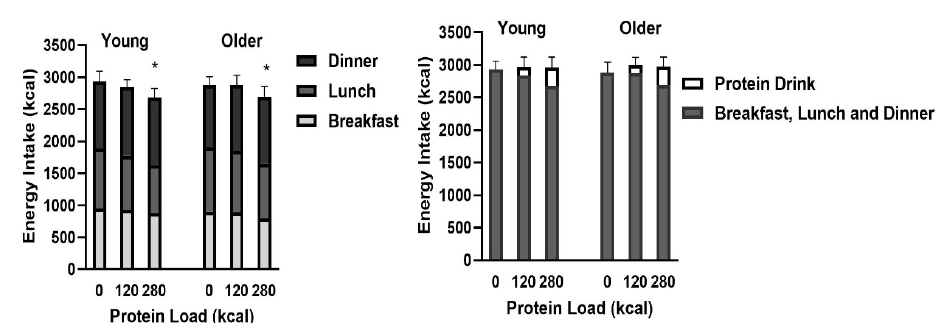
Figure 1. Energy intake at breakfast, lunch, and dinner following whey protein ingestion in healthy young and older men. Mean ( ± SEM) ad libitum energy intake (kcal; left) at breakfast (light grey bars), lunch (dark grey bars), and dinner (black bars) following drink ingestion containing flavored water (control, ~2 kcal) or whey protein (30 g / 120 kcal or 70 g / 280 kcal) and cumulative energy intake (kcal; right; sum total energy intake at breakfast, lunch, and dinner combined (dark grey bars) and protein drink (white bars)) in young (left; n = 15) and older (right; n = 15) men. Age and protein load main e ff ects and interaction e ff ects were determined by repeated measures ANOVA. * The 70 g protein drink suppressed energy intake (sum of breakfast, lunch, and dinner) compared with the control (protein load e ff ect P = 0.012, post-hoc P = 0.023).